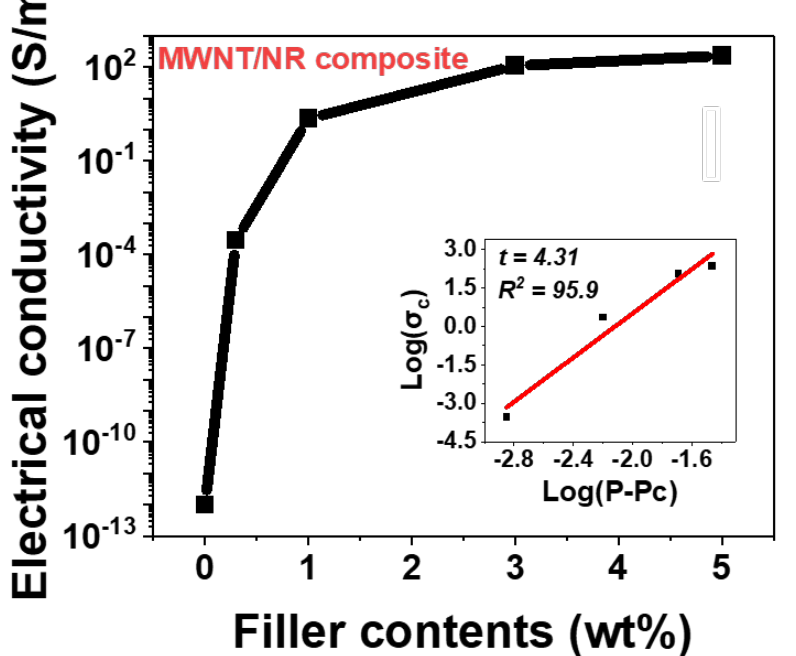
Figure 3. Electrical conductivity of MWNT/NR composites as function of contents (wt.%) and electrical percolation threshold of MWNT/NR composite. Inset image is a loglog plot: relationship between electrical conductivity of the composites and (P−Pc).